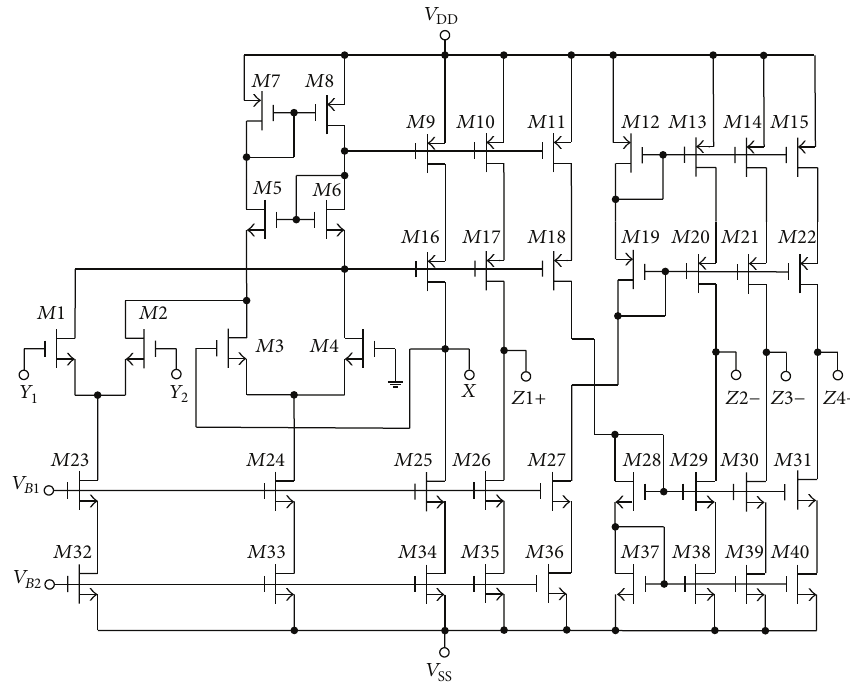
Figure 2: The CMOS implementation of the MO-DVCC.